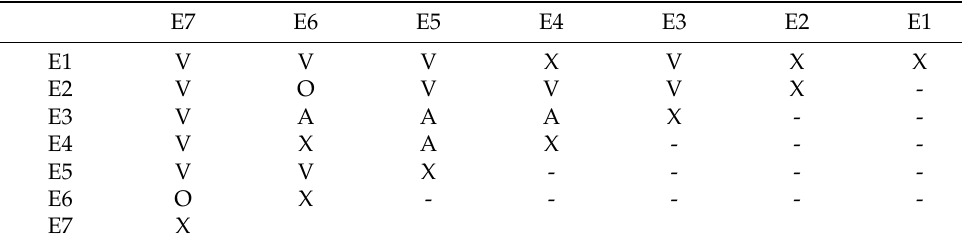
Table 4. Structural self-interaction